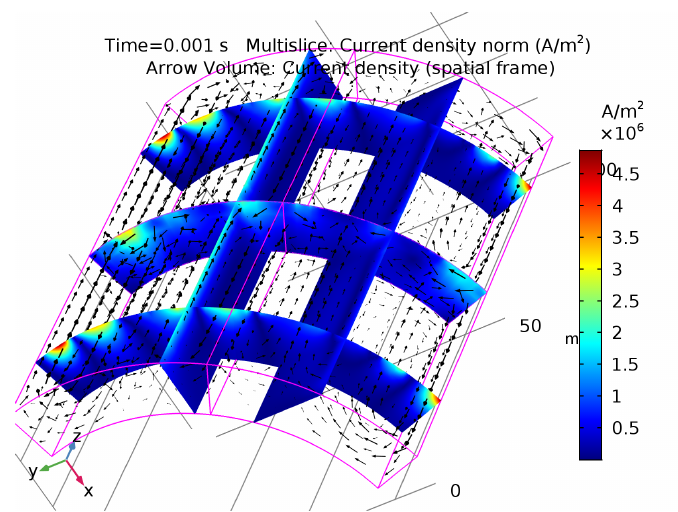
Figure 7. Effect of inner PMs segmentation on eddy currents: current density norm (multi-slice colormap) and current density vectors (black arrows). The figure refers to the 3D simulation with two axial segments and two circumferential segments.